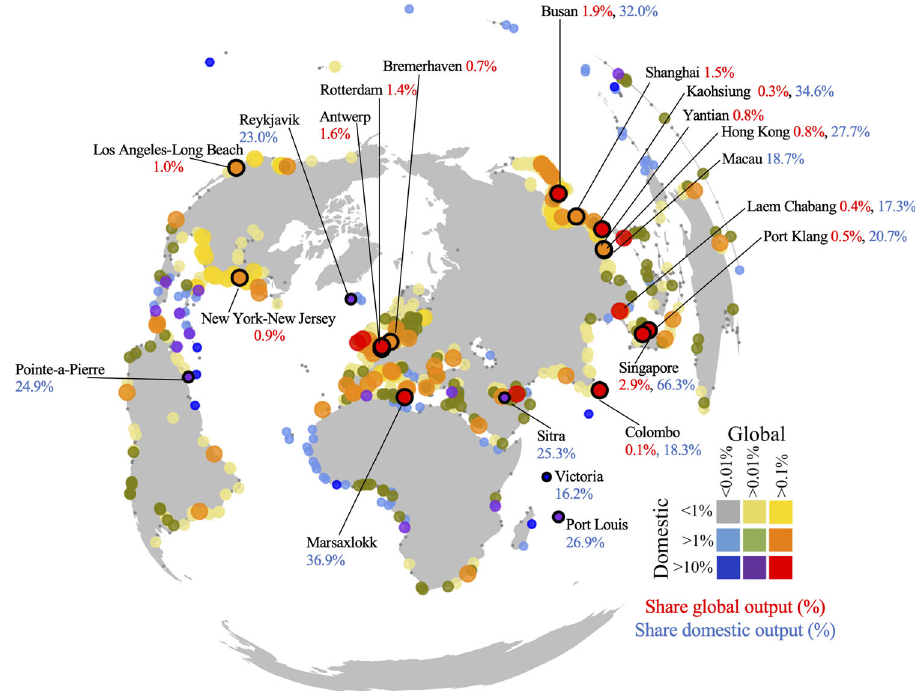
Fig. 4 | Distribution of the domestically and globally critical ports in terms of industryoutput. Theimportanceoftrade fl owsgoingthroughportsintermsofits contribution to the domestic output as a percentage of total domestic output and